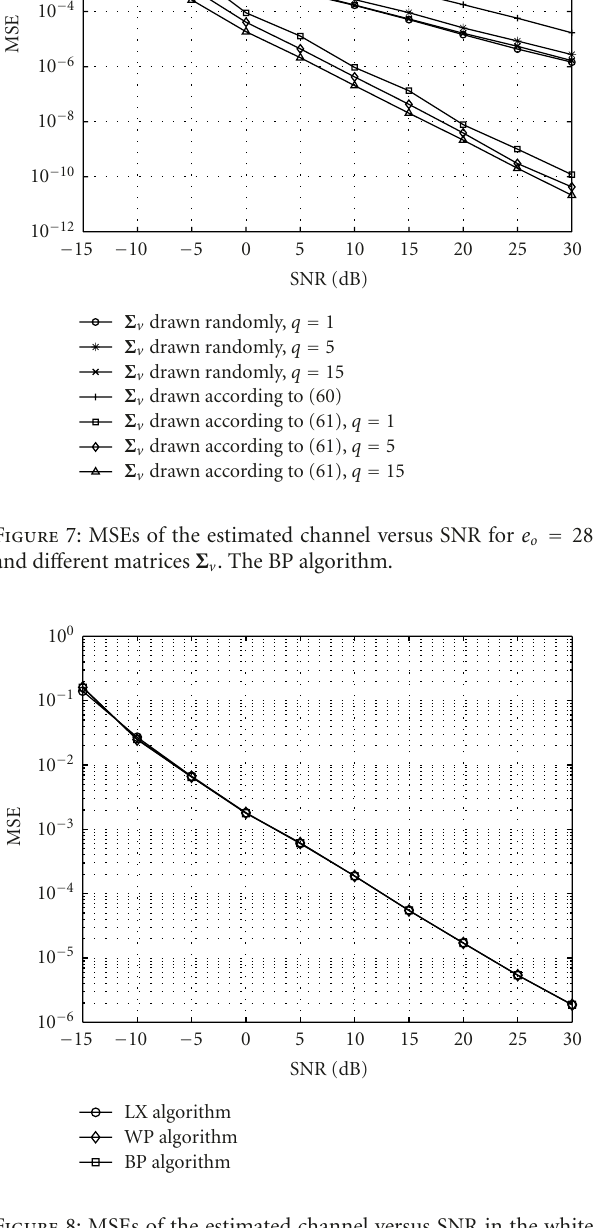
Figure 8: MSEs of the estimated channel versus SNR in the white noise environment. The LX, WP, and BP